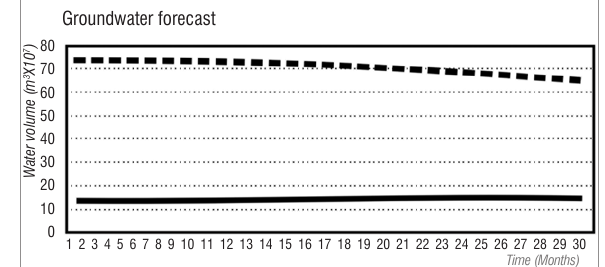
Figure 11: Graph forecasting the groundwater requirements of the hypothetical enhanced geothermal system (solid curve) and the average natural recharge rate (dashed